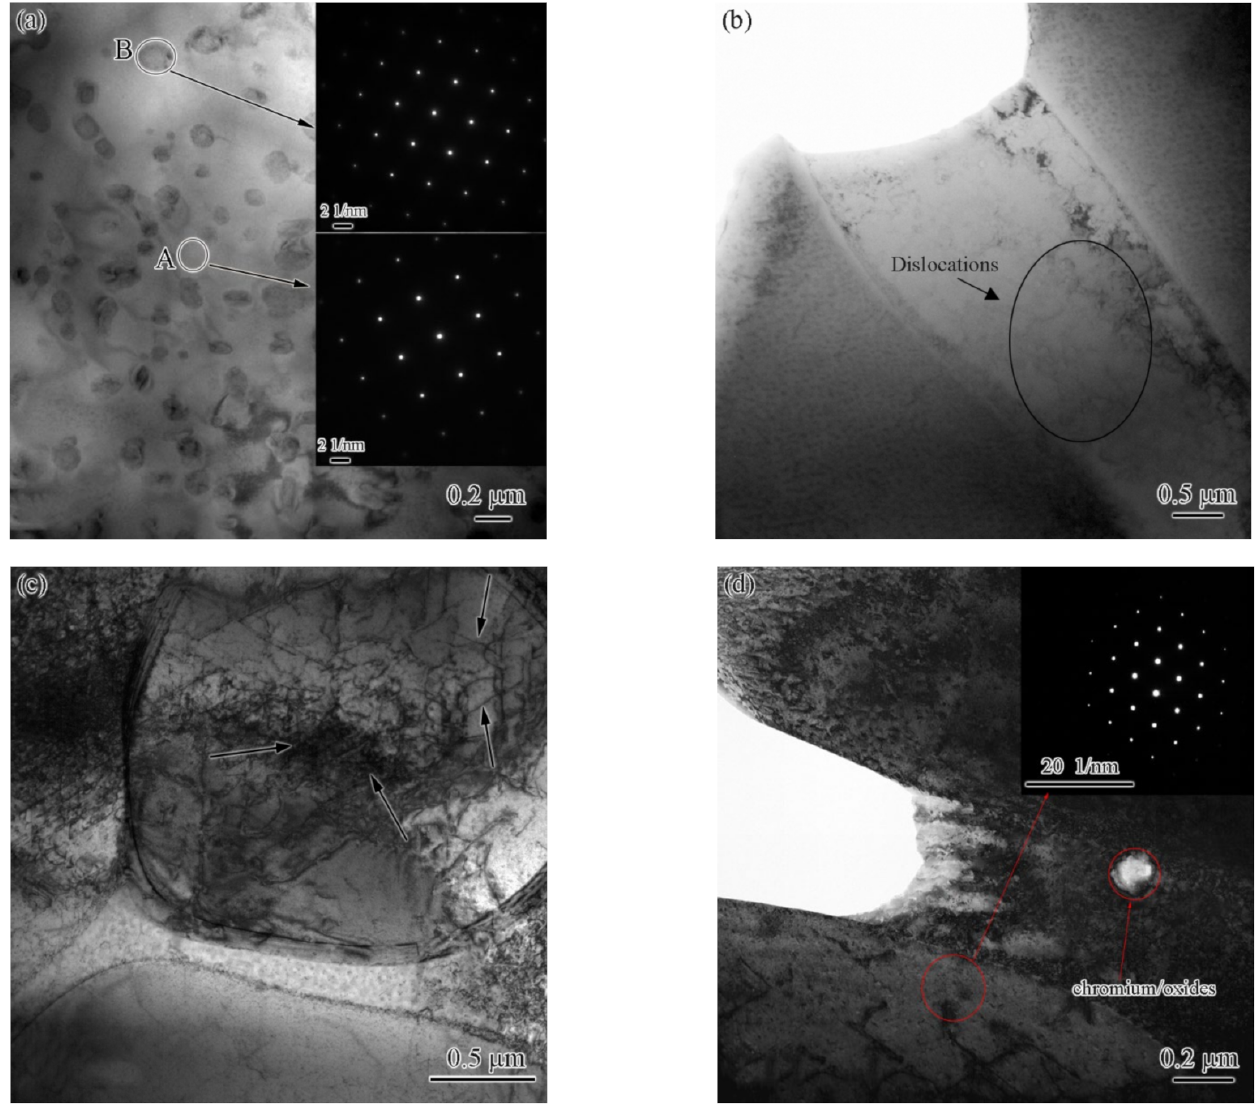
Figure 11. TEM images of ( a , b ) the BM and ( c , d ) the